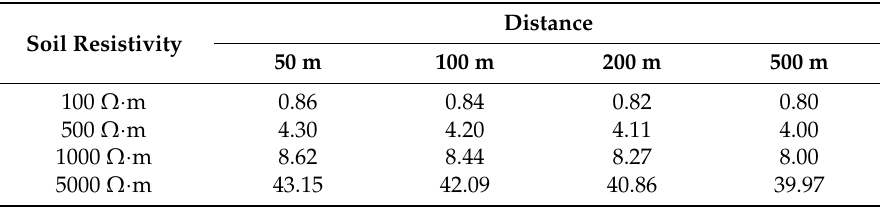
Table A4. Scenario 2b. Overall grounding